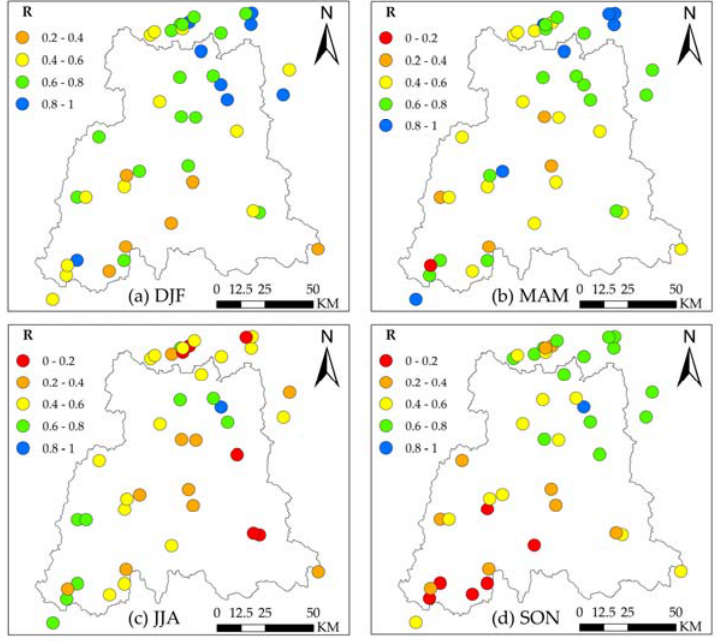
Figure 4. Pearson linear correlation coefficient (R) of ( a ) December to February; ( b ) March to May; ( c ) June to August and ( d ) September to November seasonal precipitation between the TMPA-3B43 and 42 rain gauges over the Kelantan River Basin.